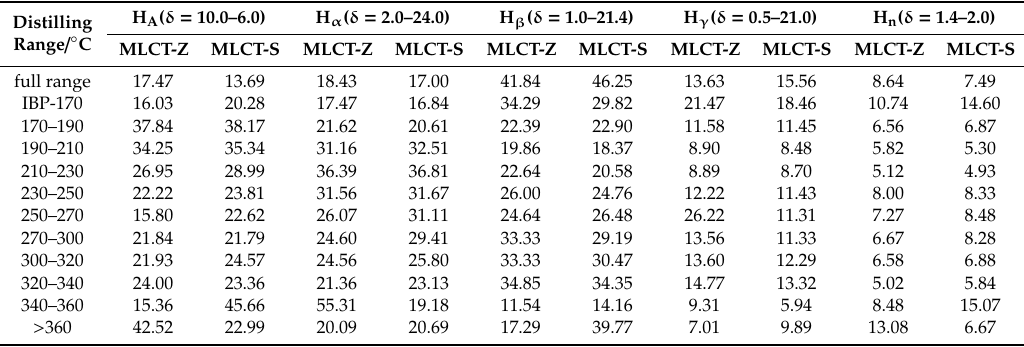
Table 3. Hydrogen types in distillate from MLCT-Z and